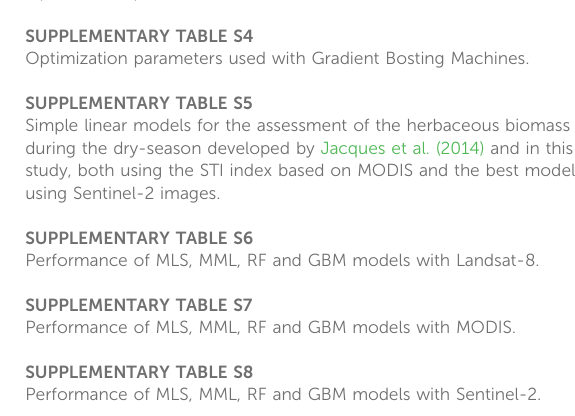
SUPPLEMENTARY TABLE S1 List of the 29 vegetation indices used in this study. SUPPLEMENTARY TABLE S2 Number of models tested to estimate BH and BT. SUPPLEMENTARY TABLE S3 Optimization parameters used with random forest. SUPPLEMENTARY TABLE S4 Optimization parameters used with Gradient Bosting Machines. SUPPLEMENTARY TABLE S5 Simple linear models for the assessment of the herbaceous biomass during the dry-season developed by Jacques et al. (2014) and in this study, both using the STI index based on MODIS and the best model using Sentinel-2 images.